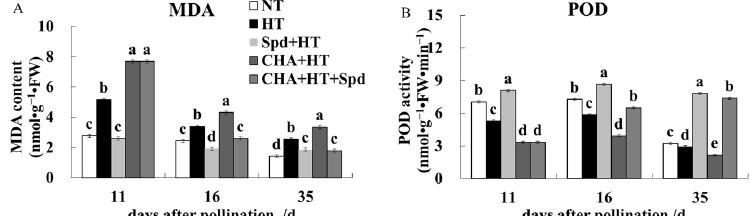
Figure 7. Effects of exogenous Spd and CHA on ( A ) the malondialdehyde (MDA) content and ( B ) antioxidant enzyme peroxidase (POD) activity of rice seeds during development under high temperature (40 °C, 5 days). The bars mean standard deviation and different letters indicate significant differences between treatments at the same developmental stage (α = 0.05, LSD). The treatment methods were the same as those in the Figure 1 notes.